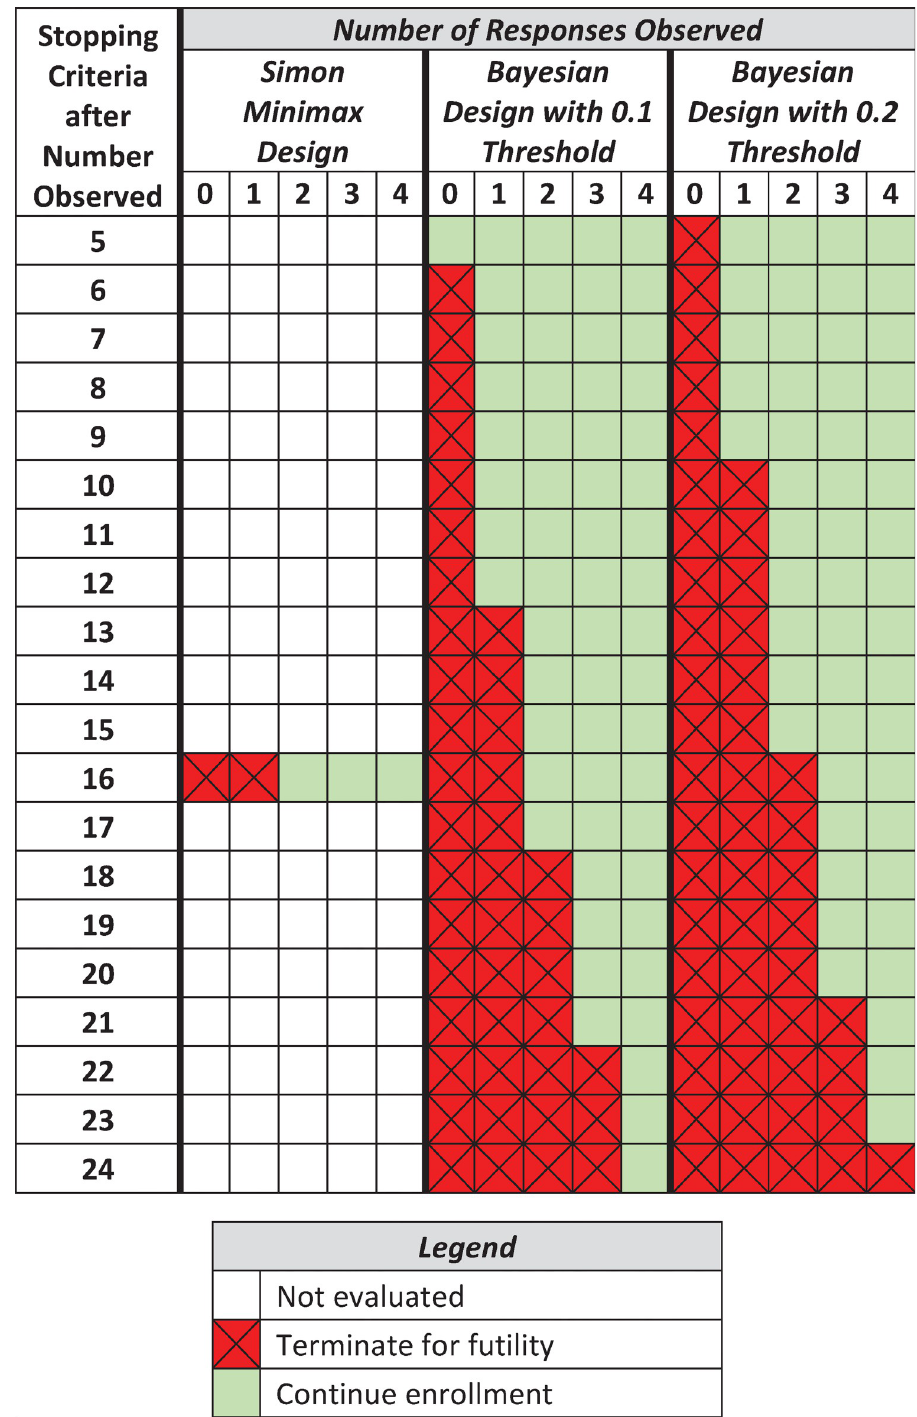
Fig 1. Comparison of sequential designs for a one-arm trial to compare a null response rate of 10% and a target response rate of 30% to achieve 90% power and a 10% type I error rate under Simon’s two-stage minimax design, which enrolls a maximum sample size of 25. Simon’s two-stage design assumes a single interim analysis after 16 participant outcomes are observed and would terminate for futility only if 0 or 1 response was observed. On the other hand, Bayesian designs with predictive probability monitoring may be more flexible. A 0.1 and 0.2 threshold are illustrated, where an arm could terminate for futility if no responses are observed within the first 6 participants for a